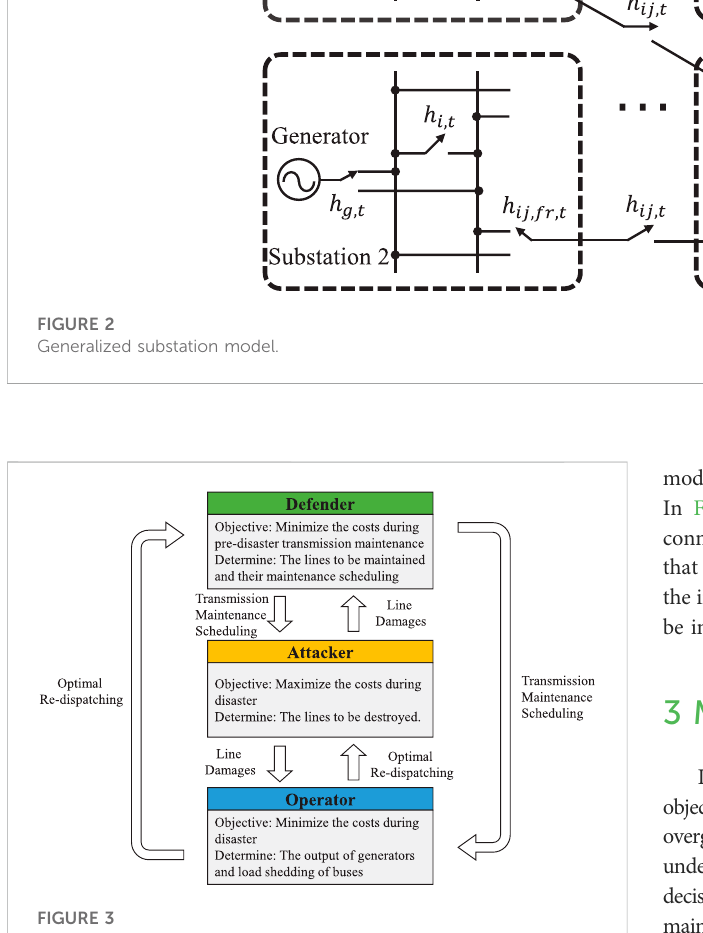
FIGURE 3 Framework of the proposed tri-level optimization